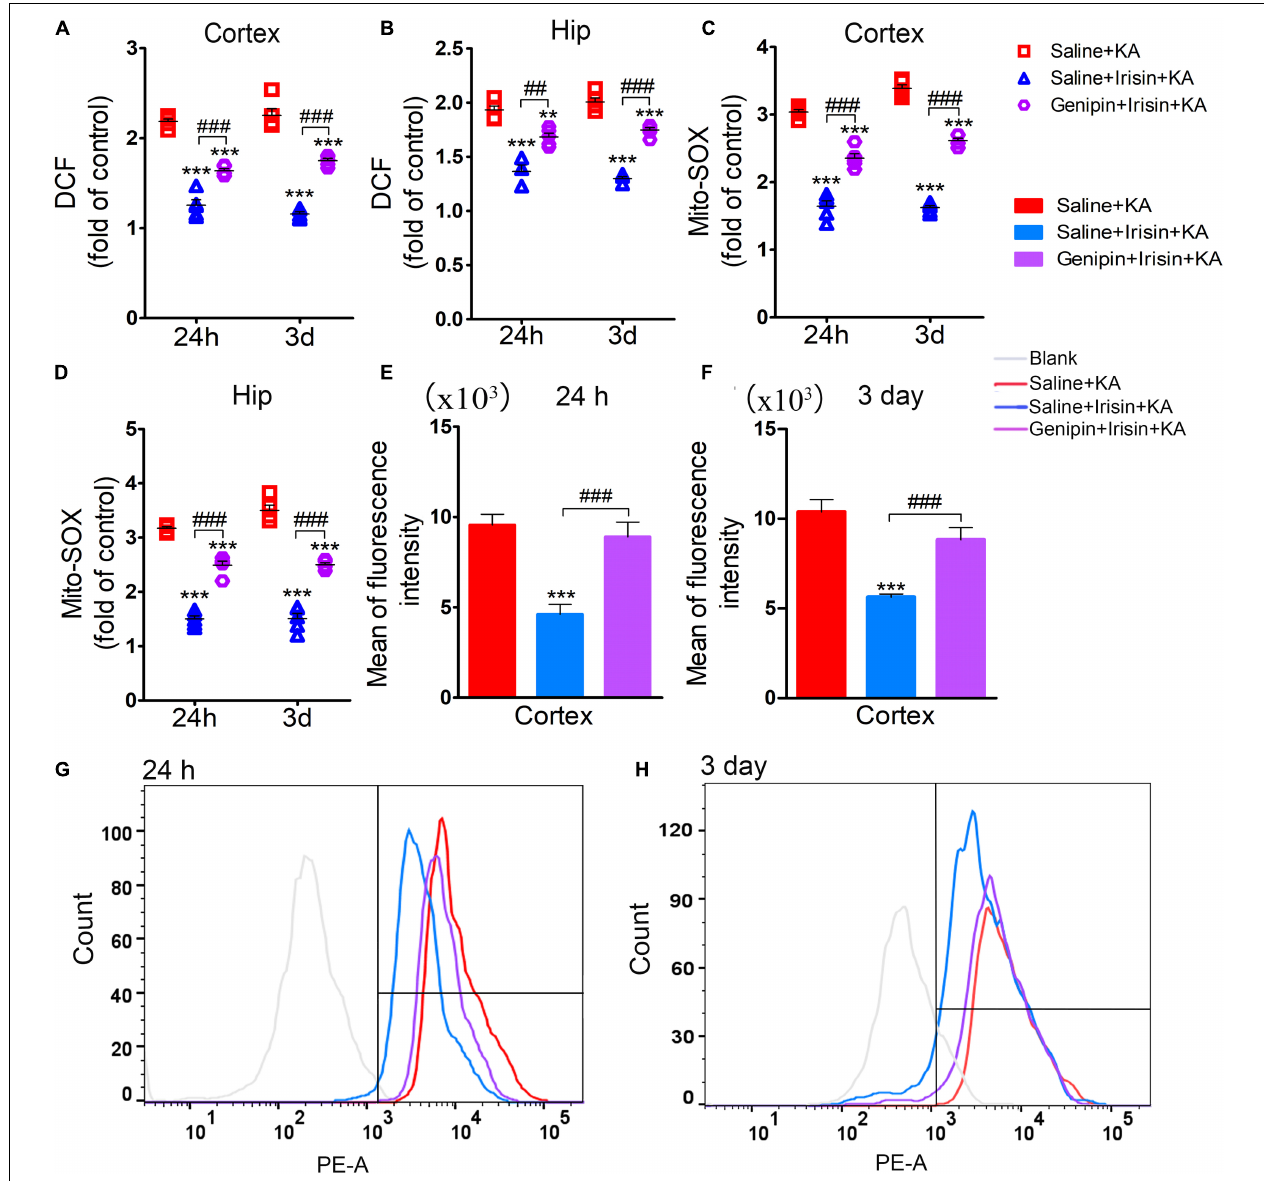
FIGURE 8 | Genipin reversed the reduced level of DCF/Mito-SOX mediated by exogenous irisin. The levels of DCF (A,B) , Mito-SOX (C,D) was detected in cortex and hippocampus after genipin administration. (E–H) Mito-SOX levels due to genipin administration were observed based on the flow cytometry analysis. 24 h, n = 5/group; 3 days, n = 8/group. ** P < 0.01, *** P < 0.001 compared with controls; ## P < 0.01, ### P < 0.001 compared with each other (One-way ANOVA with Dunnett’s T3 post hoc test). Hip,